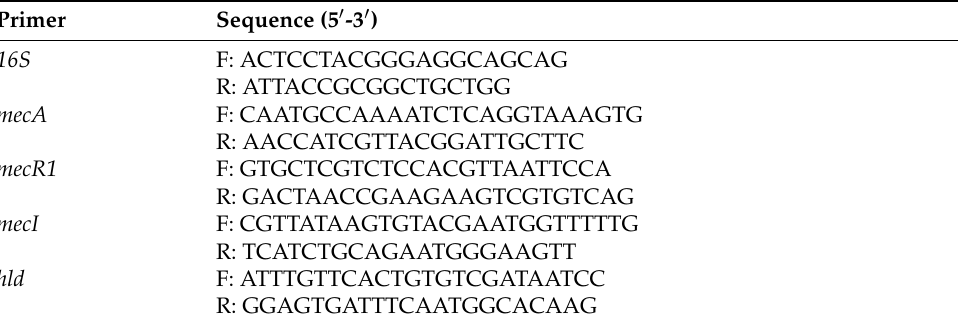
Table 2. Primers used in